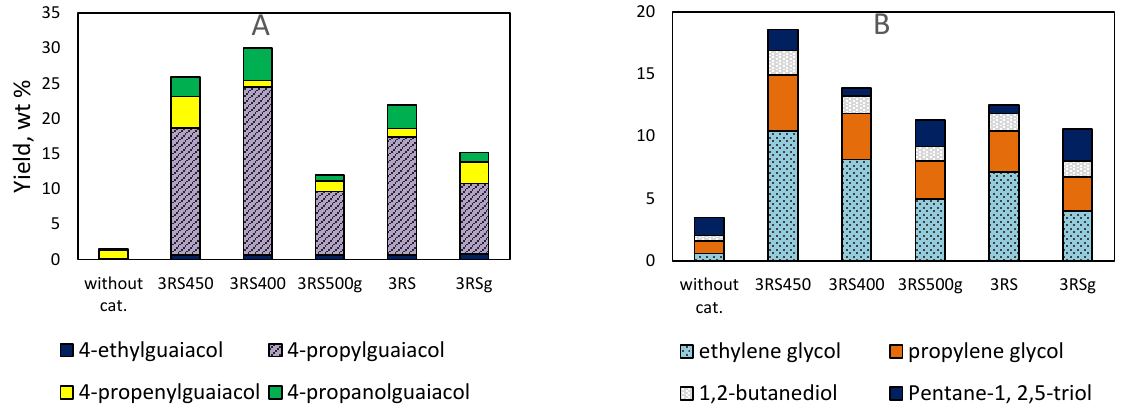
Figure 2. The yields of monomers from lignin ( A ) and polyols from polysaccharides ( B ) over the Ru catalysts.